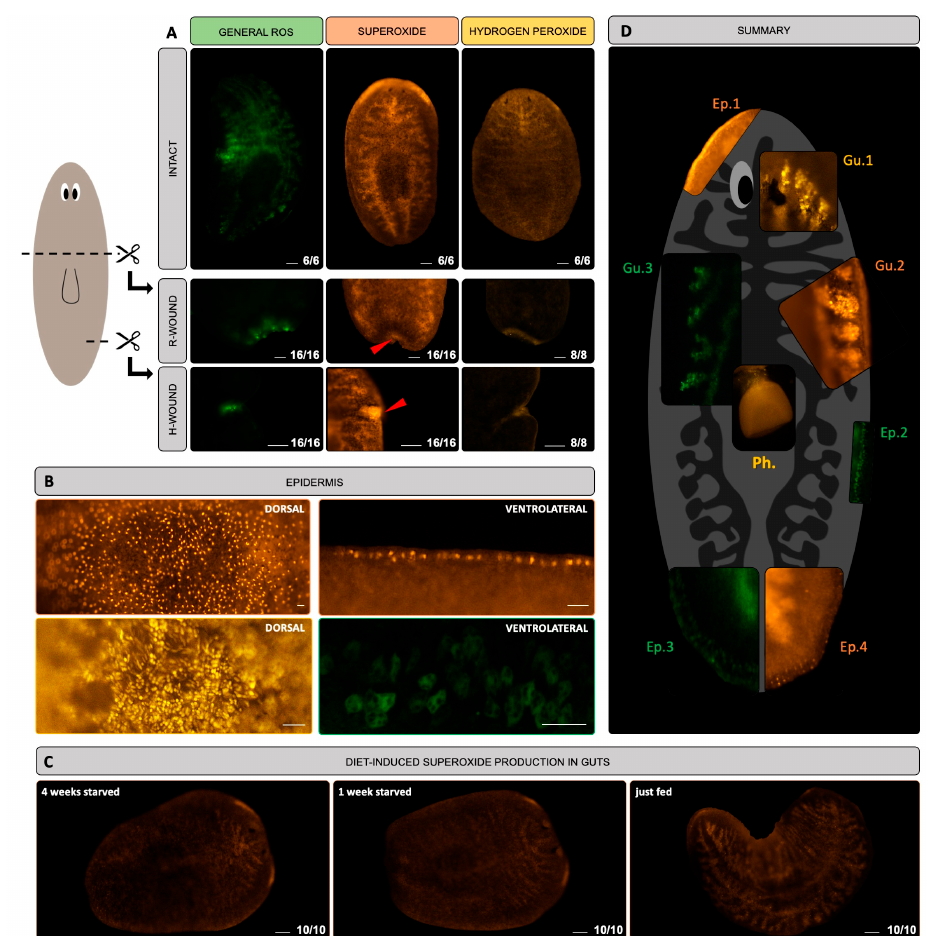
Figure 1. In vivo visualisation of reactive oxygen species (ROS) in general, and superoxide and hydrogen peroxide in specific. ( A ) Upper panel: intact animals stained for general ROS (green), superoxide (orange) and hydrogen peroxide (yellow). Middle panel: general ROS, superoxide and hydrogen peroxide production visualised in a regenerative wound (R-wound). Lower panel: general ROS, superoxide and hydrogen peroxide production visualised in a healing wound (H-wound). Scale bar repre- sents 100 µm. ( B ) Detailed images of ROS-producing epidermal structures. Pictures in the left panels are taken at the dorsal side while pictures in the right panels are taken at the ventrolateral side. The colours of the panels correspond to the different stains (green: general ROS, orange: superoxide, yellow: hydrogen peroxide). Scale bar represents 20 µm. ( C ) Influence of diet on the production of superoxide in the guts. From left to right: intact animals starved for 4 weeks, intact animals starved for 1 week, intact animals that were fed just before the staining. Scale bar represents 100 µm. All pictures were taken with the same camera and software settings. ( D ) Summary figure containing images of the different in vivo stains: green (general ROS), orange (su- peroxide) and yellow (hydrogen peroxide), visualising epidermal structures (Ep.), structures in the guts (Gu.) and pharynx (Ph.). 3. Results In this study we aimed for a detailed characterisation of ROS and AOXs present in the freshwater planarian S. mediterranea , and further elucidated their role in the regenera- tion process. In our previous work, we visualised an amputation-induced ROS burst, us- ing a general intracellular ROS stain [22]. We found that regeneration is impaired upon interfering with ROS production and that the presence of hydrogen peroxide (H 2 O 2 ) plays a role in initiating the regeneration process [46]. The current study proceeds on these find- ings and focuses on both the pro-oxidative as the antioxidative side of the redox balance. Although often ignored, knowledge of all (counter)parts is of uttermost importance to